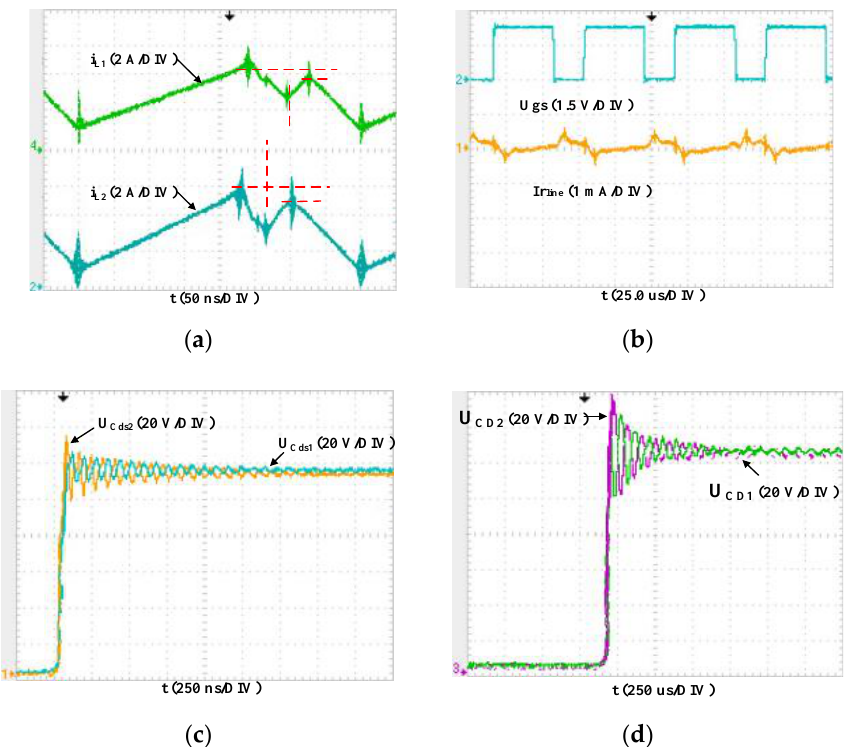
Figure 17. Experimental waveforms considering parasitic parameters for Po = 200 W after the parasitic parameter R L 2 value is changed. ( a ) Experimental waveform of inductor current. ( b ) Experimental waveform of centerline current. ( c ) Experimental waveform of MOSFET voltages. ( d ) Experimental waveform of diode voltages.